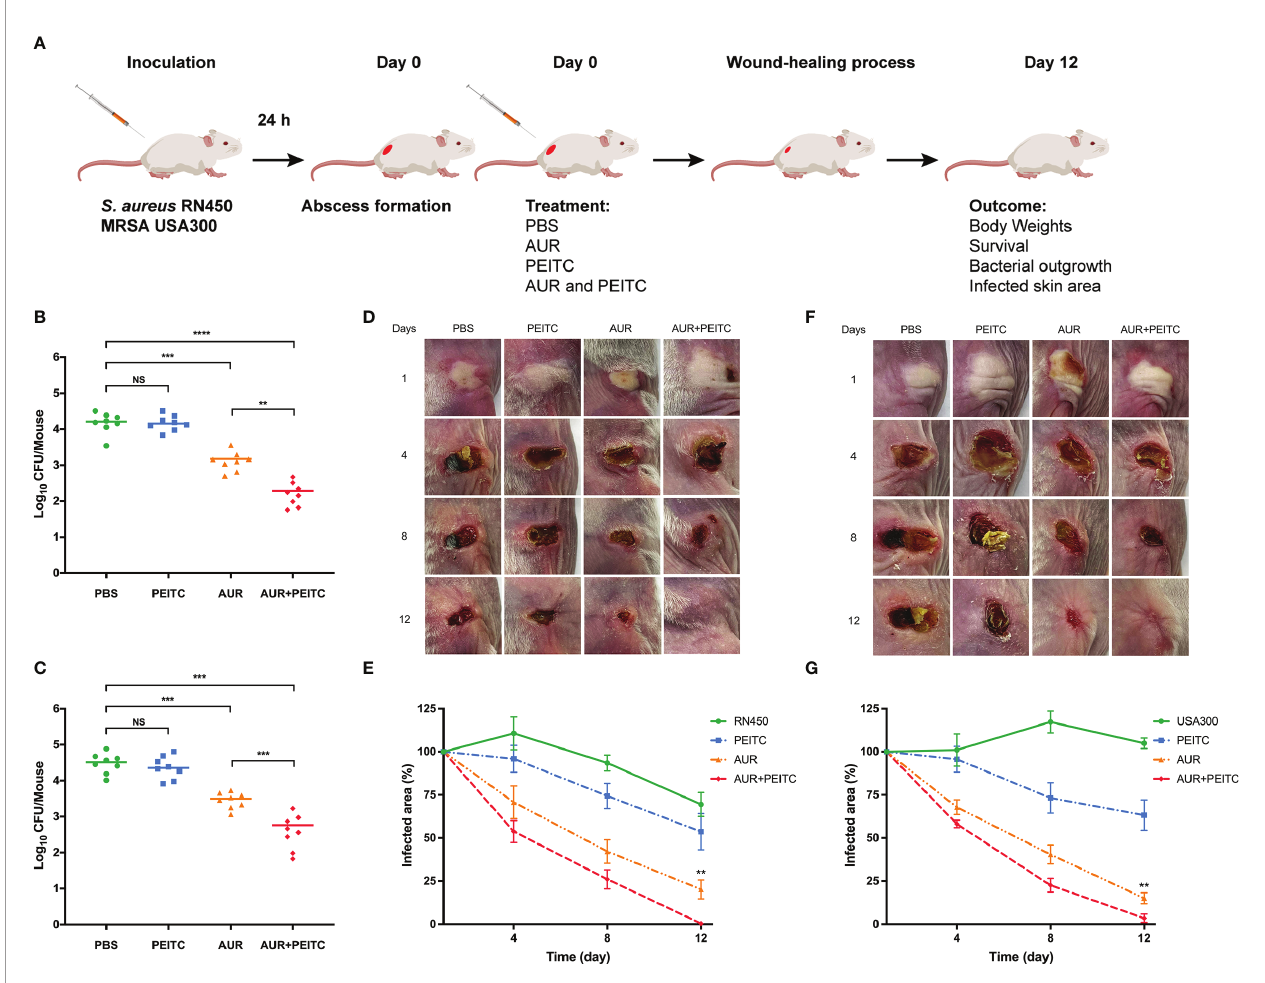
FIGURE 7 | Effect of AUR-PEITC combination on skin infections caused by S. aureus . (A) Schematic diagram of skin infection and treatment process. (B, C) Bacterial burdens in treatment with PBS, AUR, PEITC or AUR-PEITC combination at 8 days after cutaneous challenge with (B) S. aureus RN450 and (C) MRSA USA300. (D, F) Digital photographs showing changes in the infected skin of mice at 0, 4, 8, 12 days after exposure to different treatments. (E, G) Quanti fi cation of the area of the infected skin of mice from each treatment group over time. (D, E) S. aureus RN450; (F, G) MRSA USA300. (B, C, E, G) Data are from three independent experiments. The group size was 8 mice. (D, F) One experiment is representative of three independent experiments. **P < 0.01, ***P < 0.001, ****P < 0.0001. Control, untreated control; NS, no signi fi cance; PBS, treated control. AUR, aurano fi n; PEITC, phenethyl